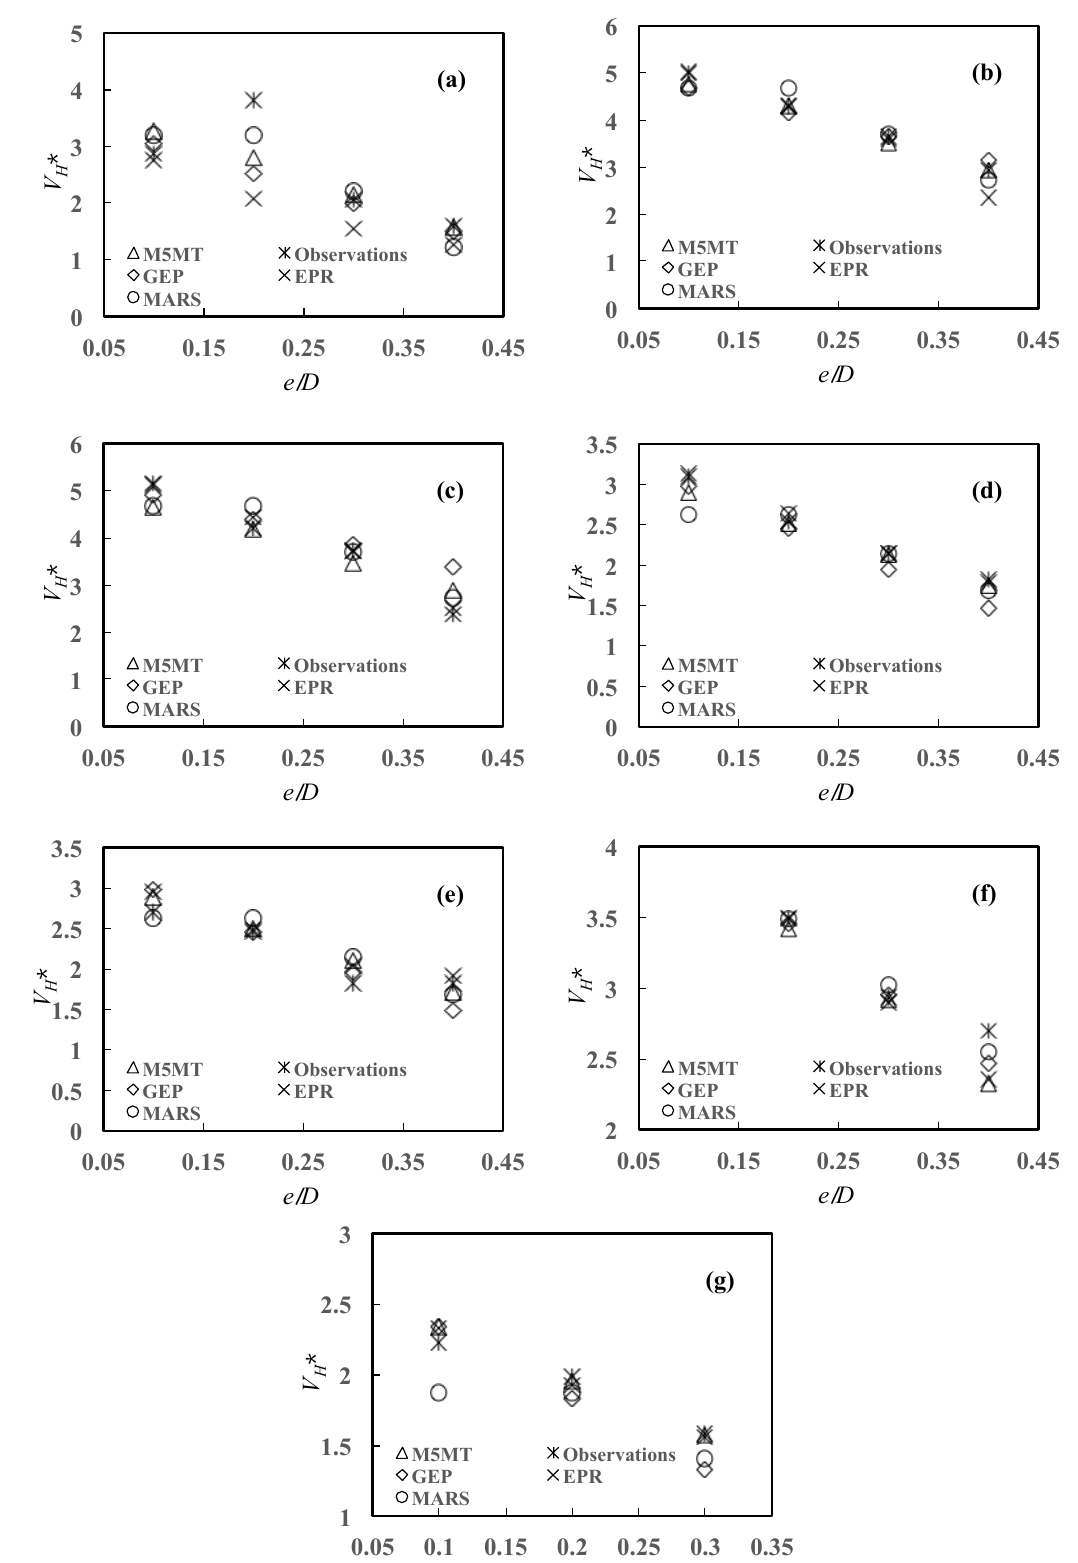
Figure 8. Variations of 𝑉 𝐻∗ against 𝑒 𝐷⁄ at: ( a ) KC = 8.7 and α = 0°, ( b ) KC = 15.8 and α = 0°, ( c ) KC = 18.0 and α = 0°, ( d ) KC = 15.8 and α = 30°, ( e ) KC = 18.0 and α = 30°, ( f ) KC = 18.0 and α = 15°, and ( g ) KC = 15.8 and α = 45°.